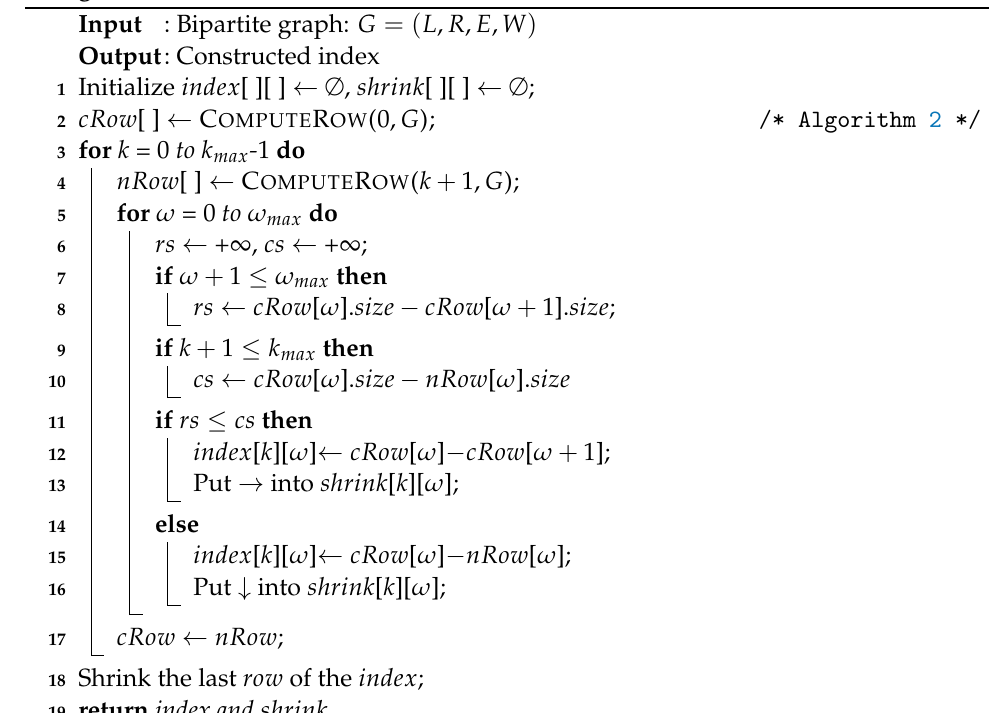
Algorithm 3 : O PTION I NDEX C ONSTRUCTION A